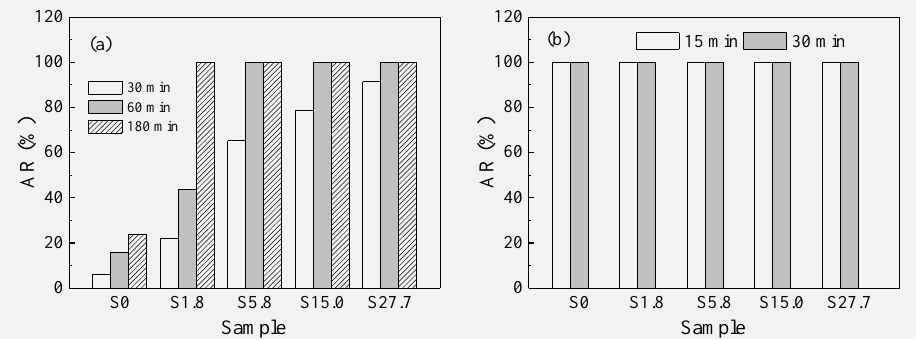
Figure 6. Antibacterial ratio of the film samples tested by agar plate counting method at 20 C: ( a ) closed wet conditions, ( b ) open-air conditions.